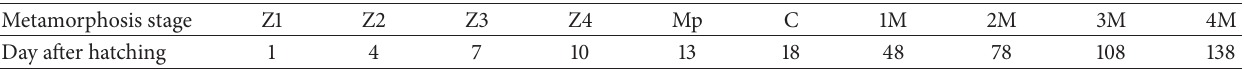
Table 2: Experimental periods of P. pelagicus during metamorphosis at different larval stages of zoea (Z1–Z4), megalopa (Mp), first crab (C), and different adult stages